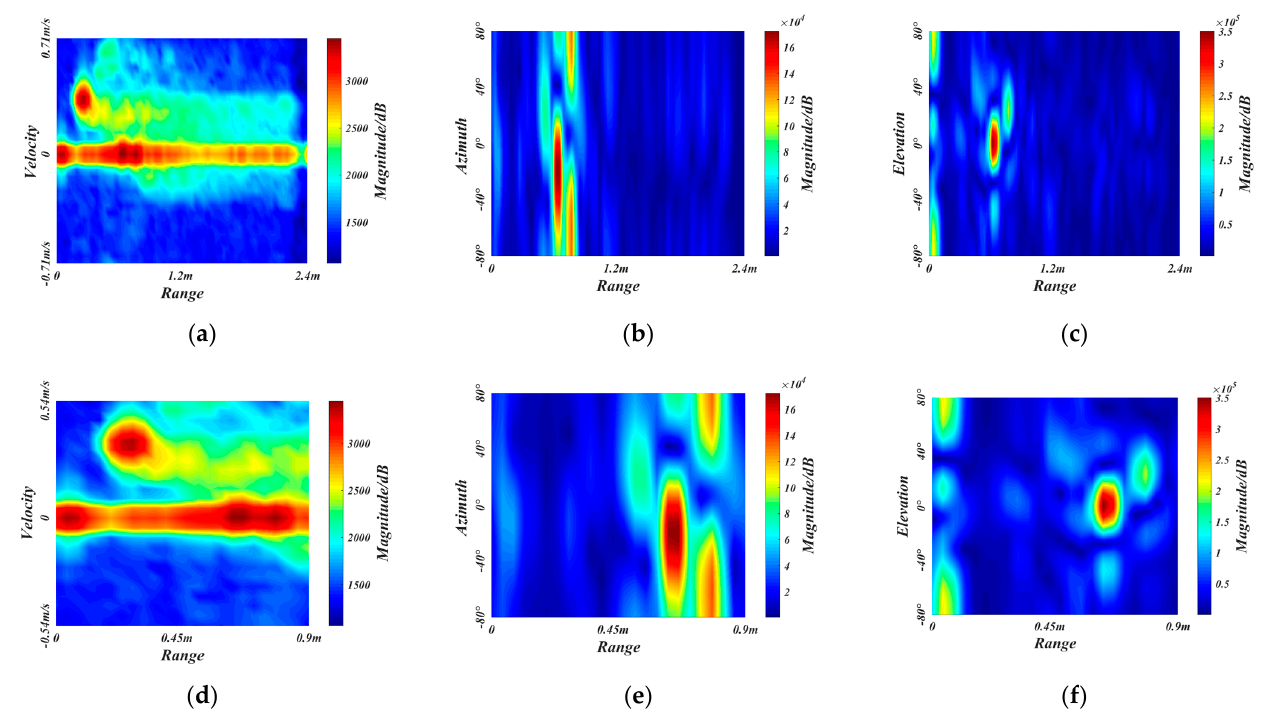
Figure 7. The ROI extraction. ( a – c ) are the original RDM, RAM, and REM, respectively. ( d – f ) are the ROI extraction results of RDM, RAM, and REM, respectively.